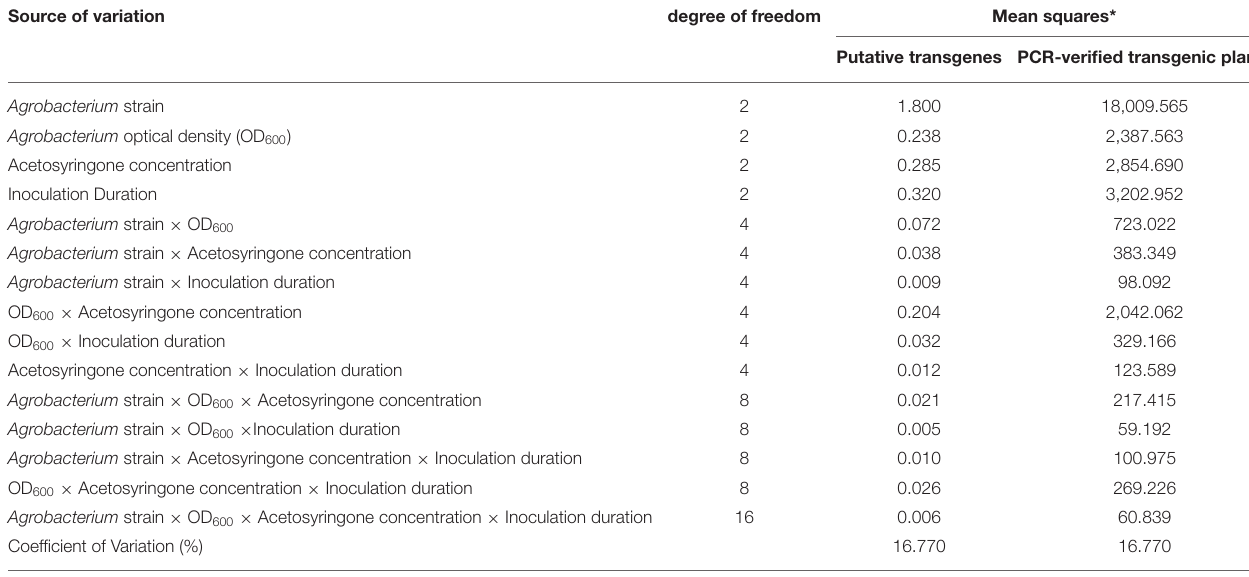
TABLE 1 | Analysis of variance (ANOVA) of the percentage of putative and PCR-verified transgenic tobacco plants under the main and interactive effects of parameters investigated. Source of variation